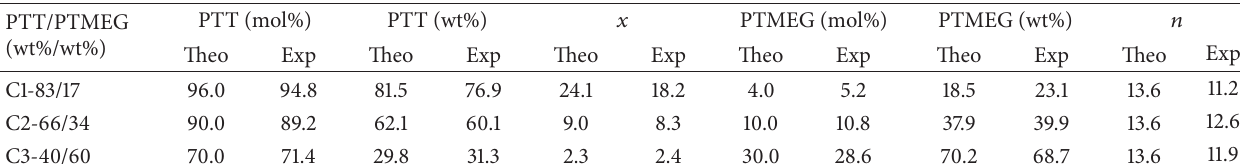
Table 2: The composition of the synthesized PTT-PTMEG copolymers determined from 1 H NMR spectra.